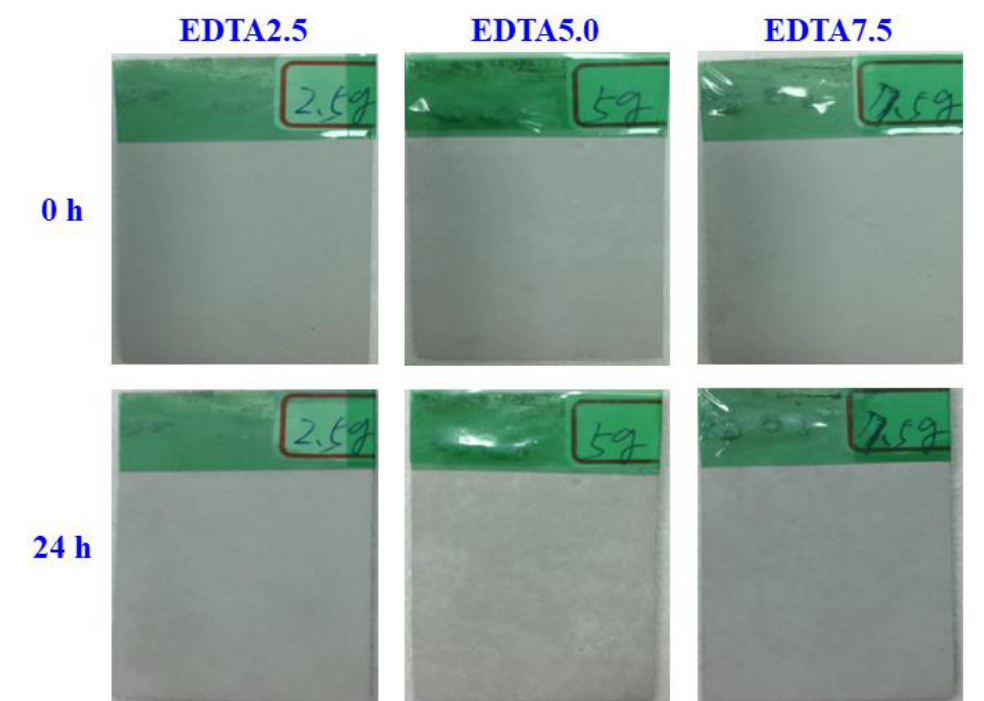
Figure 5. Visual images of the Ca-P containing MAO samples treated in the EDTA 2.5, 5.0, and 7.5 g bath after 24 h of the salt spray test.